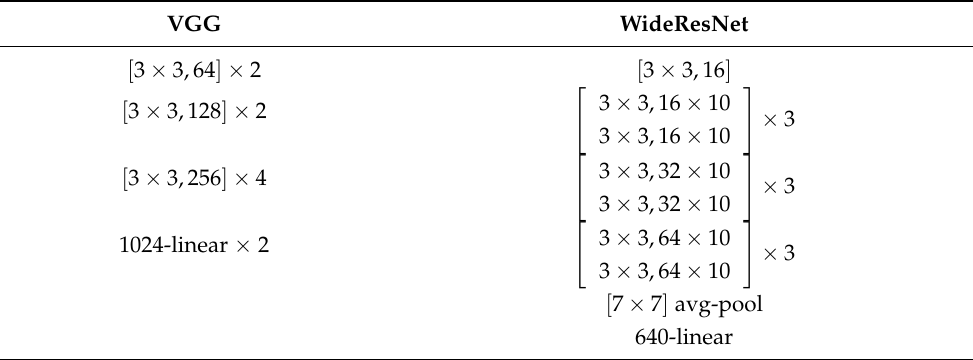
Table 4. Network configuration of the downsized VGG and the 22-layer WideResNet.